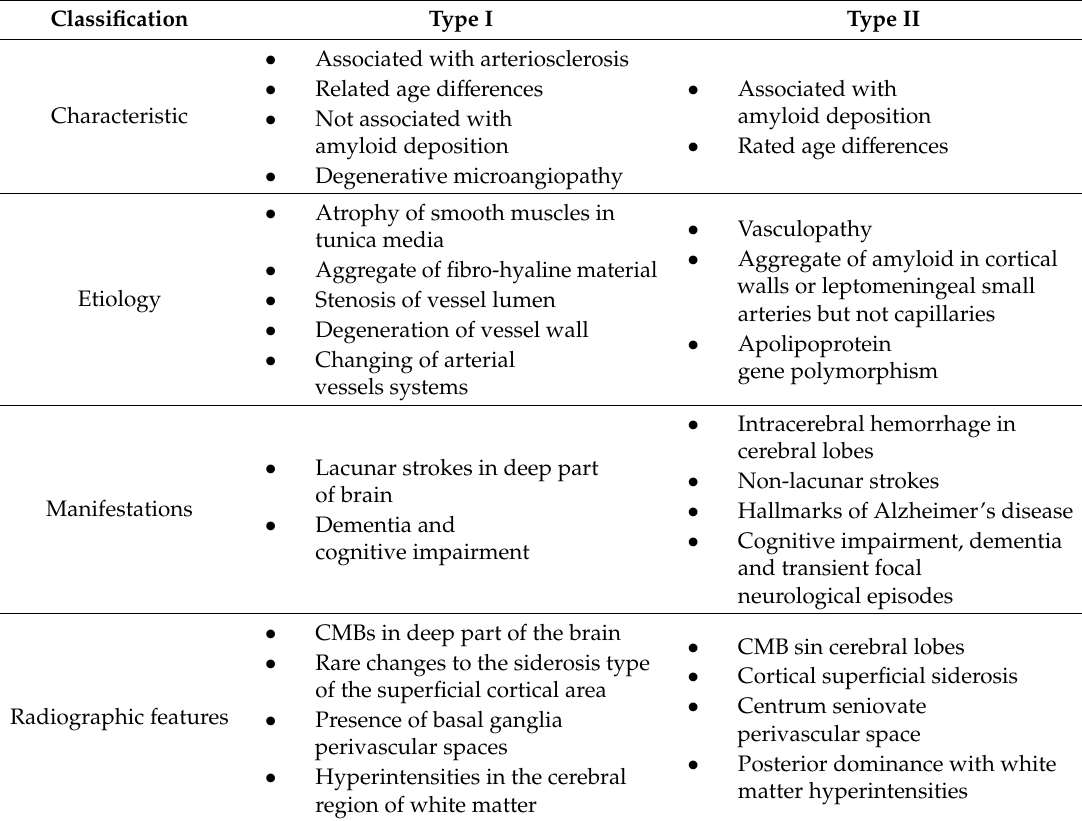
Table 2. Comparison of the two most common types of CVSD with clinical and neuroimaging characteristics. CVSD—cerebral small vessel disease, CMBs—cerebral